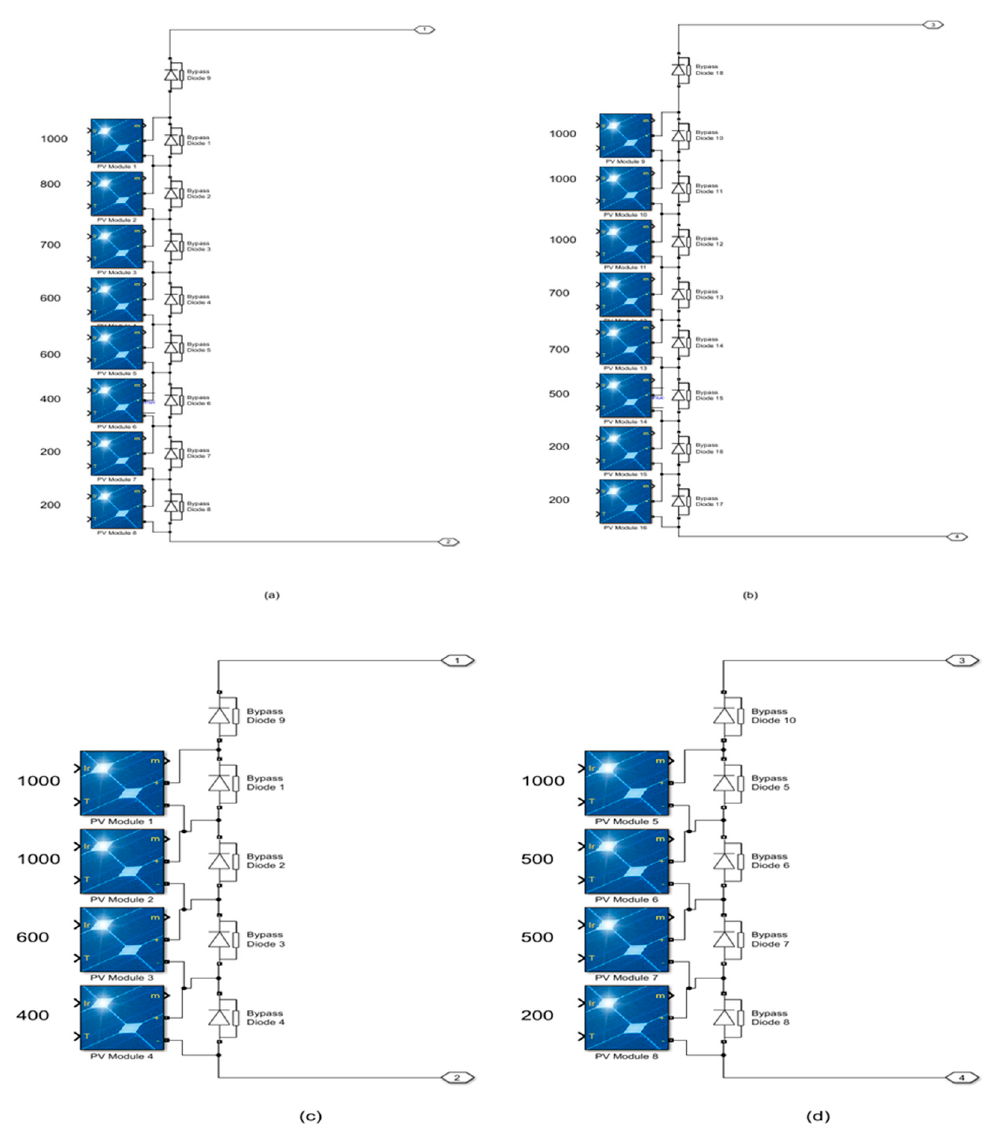
Figure 16. Shading condition cases of two configurations: ( a ) The first case of (8S); ( b ) The second case of (8S); ( c ) The first case of (4S); and ( d ) The second case of (4S).